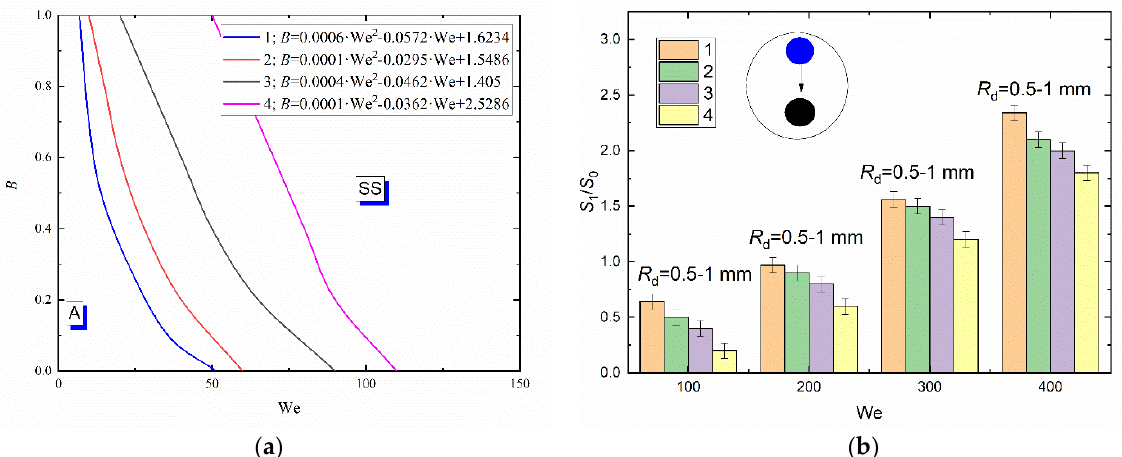
Figure 5. Collision regime maps for liquid droplets interacting with solid particles ( a ) and ratios of free surface areas after ( S 1 ) and before ( S 0 ) the head-on collision with B = 0 ( b ) at varying viscosities of liquid and constant size of droplets: 1—distilled water; 2—10 vol% glycerol solution; 3—25 vol % glycerol solution; 4—50 vol % glycerol solution.